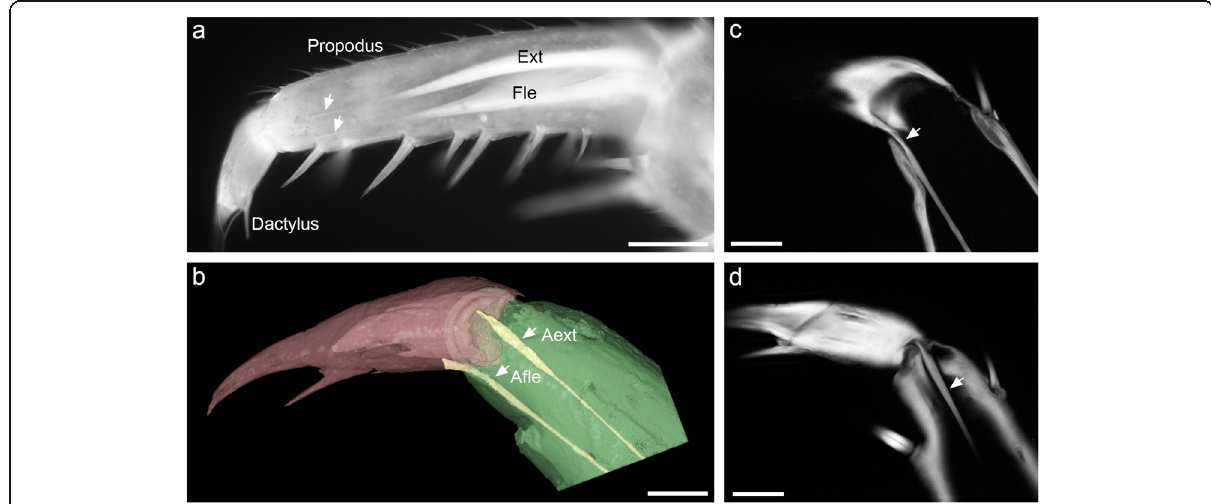
Fig. 3 Muscles that move the dactylus. a Fluorescence micrograph of a pereopod of Porcellio scaber , showing the flexor (Fle) and extensor (Ext) muscles of the dactylus. Each muscle attaches to a long apophysis (arrows). b Apophyses (yellow), shown in a 3D reconstruction of the propodus-dactylus joint. The apophysis of the flexor (Afle) attaches ventrally in the medial region and the apophysis of the extensor (Aext) dorsally in the anterior region of the dactylus. c Optical section through the medial region of the joint, showing the apophysis of the flexor (arrow). The dorsal margin of the joint is to the upper right of the image. d Optical section through the anterior region of the joint, showing the apophysis of the extensor (arrow). Scale bars: 100 μ m (a), 50 μ m (b, c,